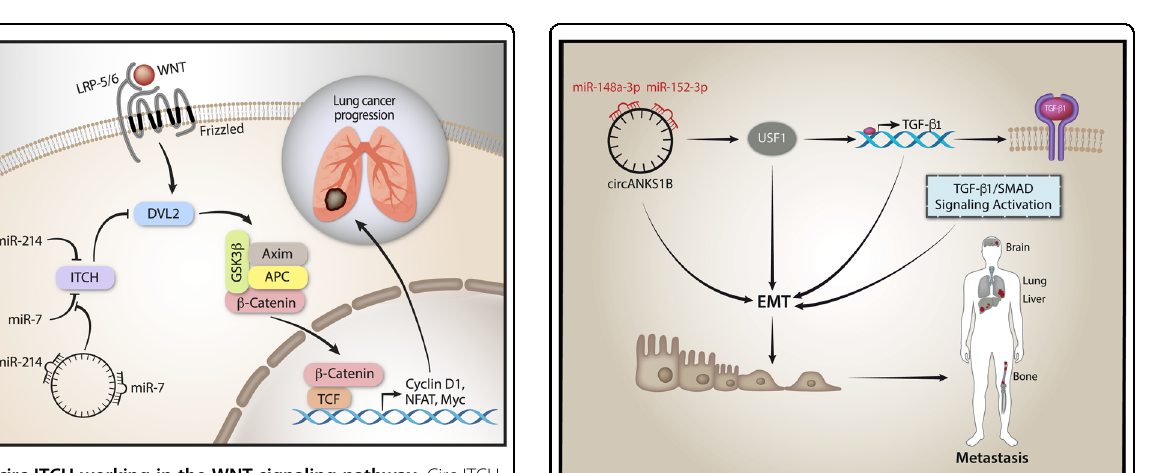
Fig. 2 circ-ITCH working in the WNT signaling pathway. Circ-ITCH negatively regulates the canonical Wnt signaling in lung cancer by sponging miR-7 and miR-214 and regulating the expression of ITCH.